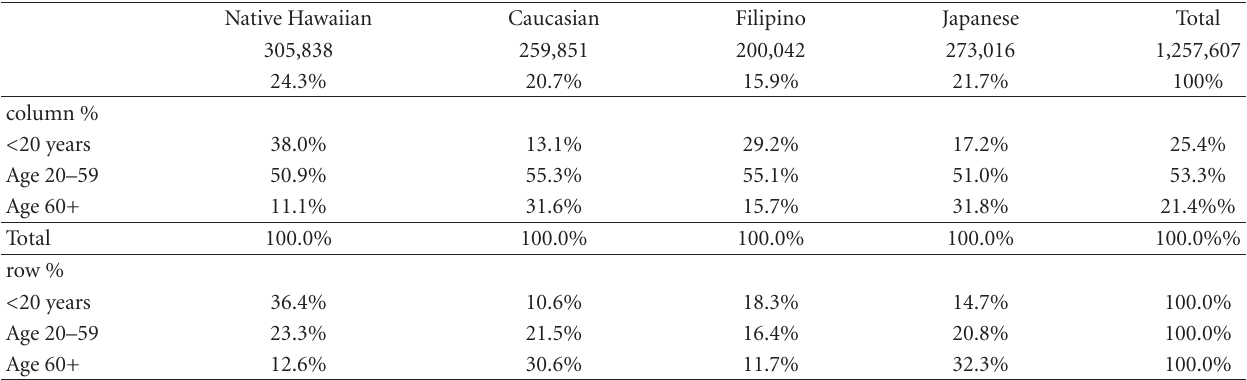
Table 1: Population totals and distributions of young people, adults, older adults by four largest ethnic groups, Hawaii, 2008. Native